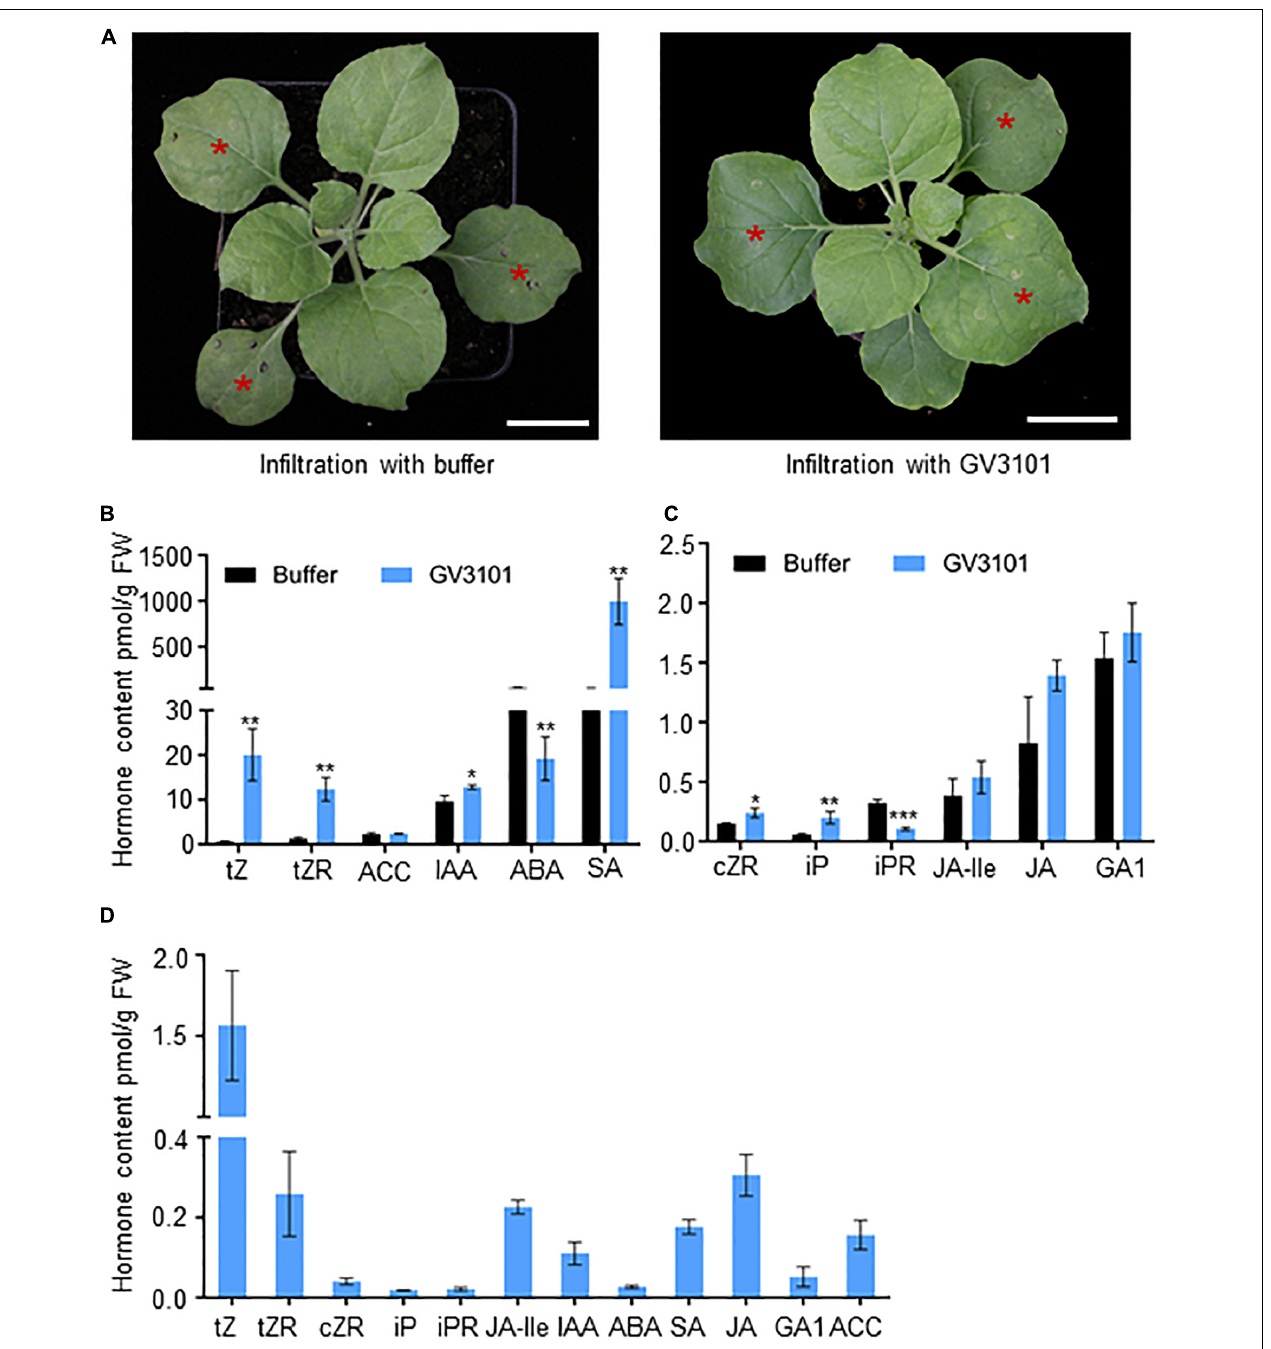
FIGURE 1 | Exported hormones from tobacco leaves infiltrated with Agrobacterium GV3101. (A) Tobacco leaves 3 days after infiltration with mock and Agrobacterium GV3101 (GV3101) harboring free GFP. Bar = 2 cm. The leaves with a red star (*) are infiltrated leaves. (B,C) Hormone profiling (pmol/g fresh weight) of the tobacco leaves in (A) . Data are means ± SE ( n = 3). (D) Quantification of hormones released from infiltrated tobacco leaves. Data are means ± SE ( n = 5). *, **, and *** indicate P -values of P < 0.05, P < 0.01, and P < 0.001, respectively, from Student’s t -test.